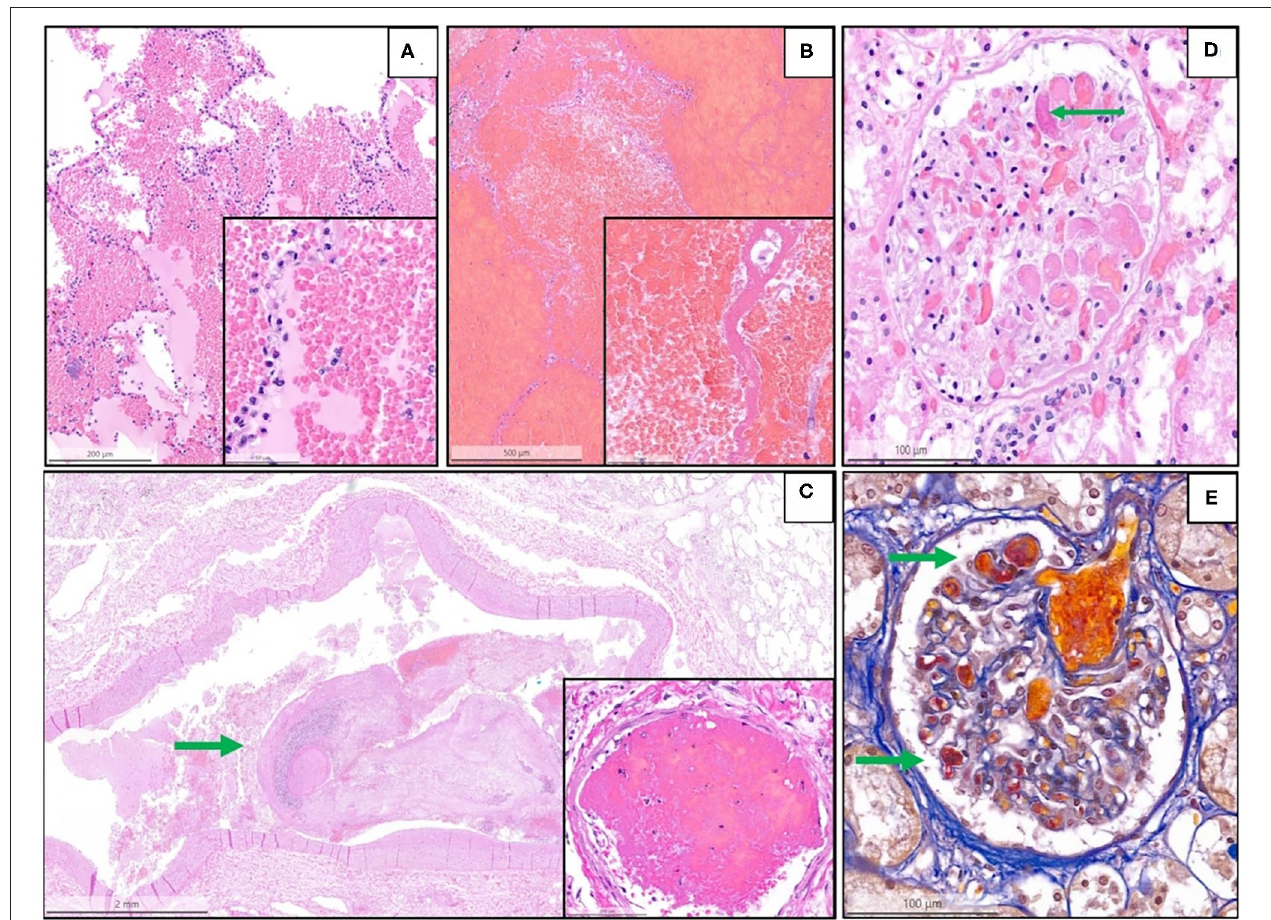
FIGURE 3 | Representative histopathological findings in autopsies from the second wave. (A) Acute pulmonary hemorrhage (H&E, magnification 10 x); the inset shows erythrocytes invading alveolar spaces (magnification 40 x). (B) Acute hemorrhagic pulmonary infarct (H&E, magnification 5 x); the inset shows a necrotic alveolar septum and hemorrhagic effusion in alveolar space (magnification 40 x). (C) Large thrombus (arrow) in a lung arteriole (H&E, magnification 1.4 x); the inset shows a fibrin thrombus in a lung capillary (magnification 28 x). (D) Glomerulus (kidney) with fibrin microthrombus (arrow) in a glomerular capillary (H&E, magnification 25 x). (E) Acid fuchsin orange G stain (AFOG-stain) shows several fibrin microthrombi (arrows) in the glomerular capillaries (magnification 25